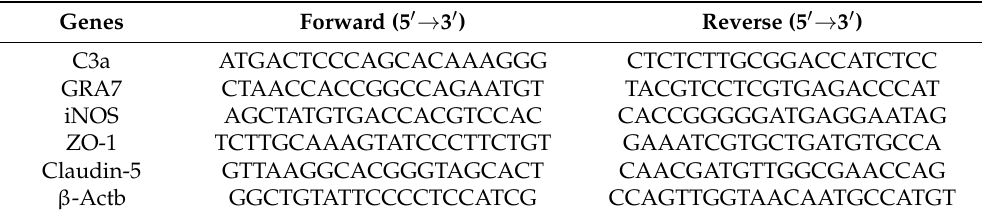
Table 1. The primer sequences of C3a, GRA7, iNOS, ZO-1, Claudin-5, and β -Actb used in quantita- tive